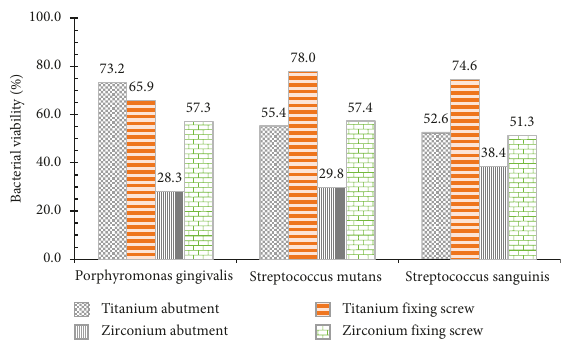
Figure 1: Bacterial viability of Streptococcus mutans (ATCC 25175), Streptococcus sanguinis (ATCC 10556), and Porphyr- omonas gingivalis (ATCC 33277) on the abutment surface and fixing screw of titanium and